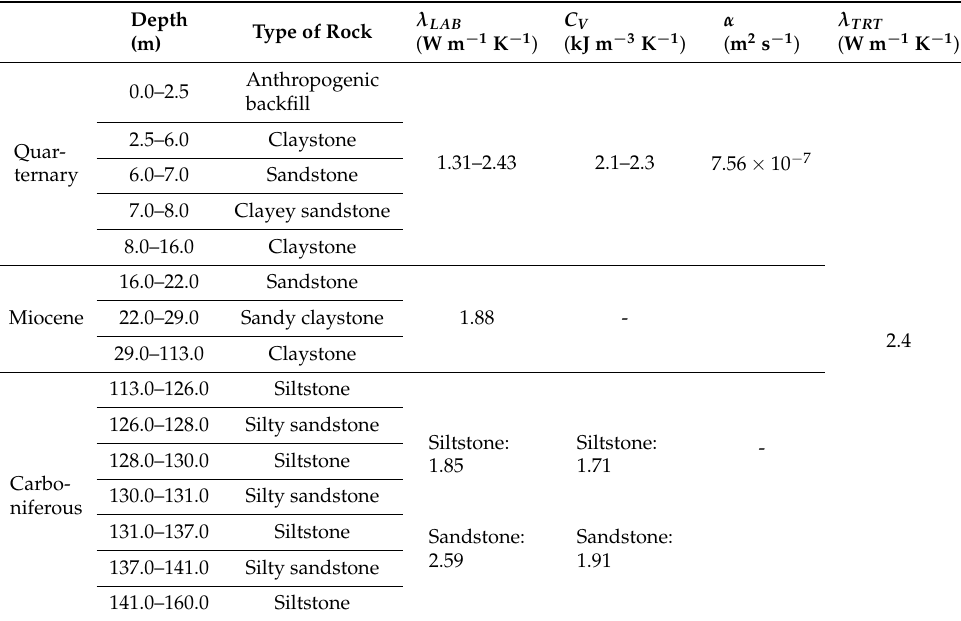
Table 4. Detailed geological profile of Small Research Polygon as per borehole A0 [4], with representa- tive physical parameters of the